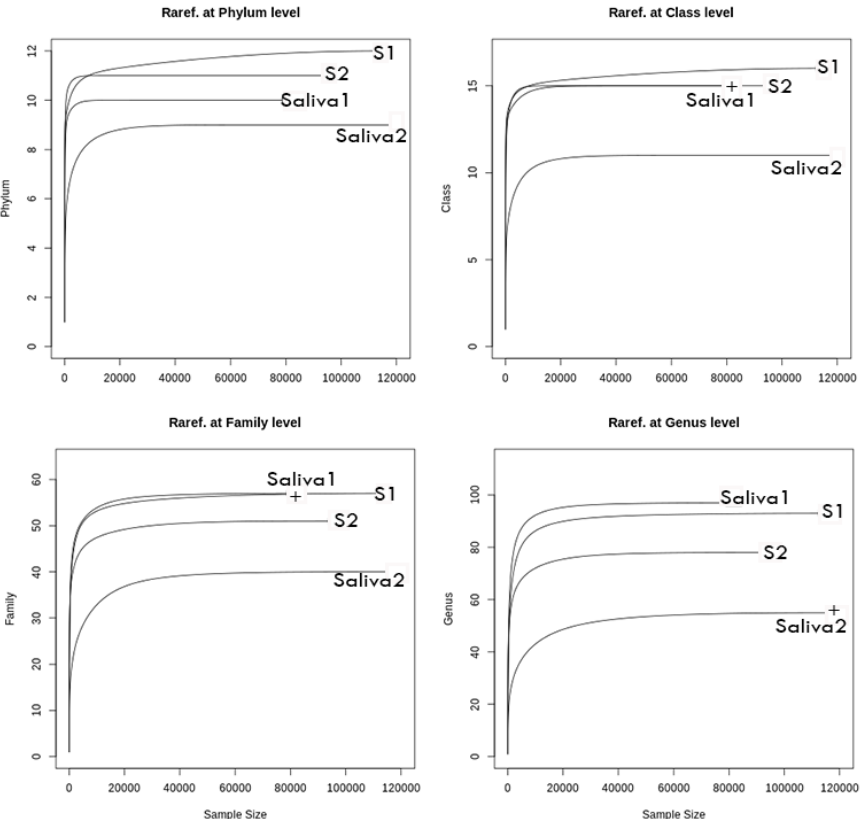
Figure 3. General rarefaction graphs. Rarefaction analysis permits estimating the overall diversity covered by the obtained squences. The figures represent the number of sequences (x axis) versus the number of taxa (y axis). S1, baseline subgingival sample; S2, post-therapy subgingival sample; Saliva 1, baseline saliva sample; Saliva 2, post-therapy saliva sample.